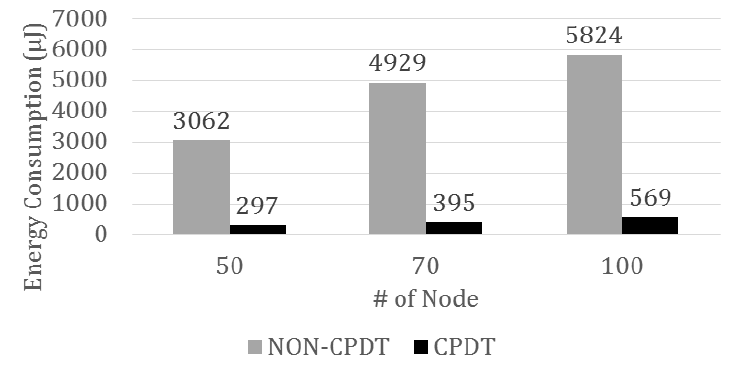
Figure 9. Average energy consumption per round.